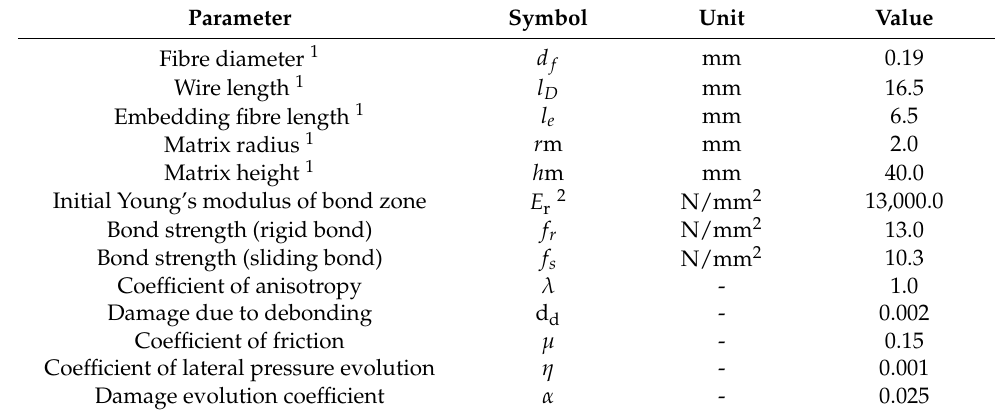
Table 4. Geometrical and material parameters for simulation of pullout test (data from [27]).